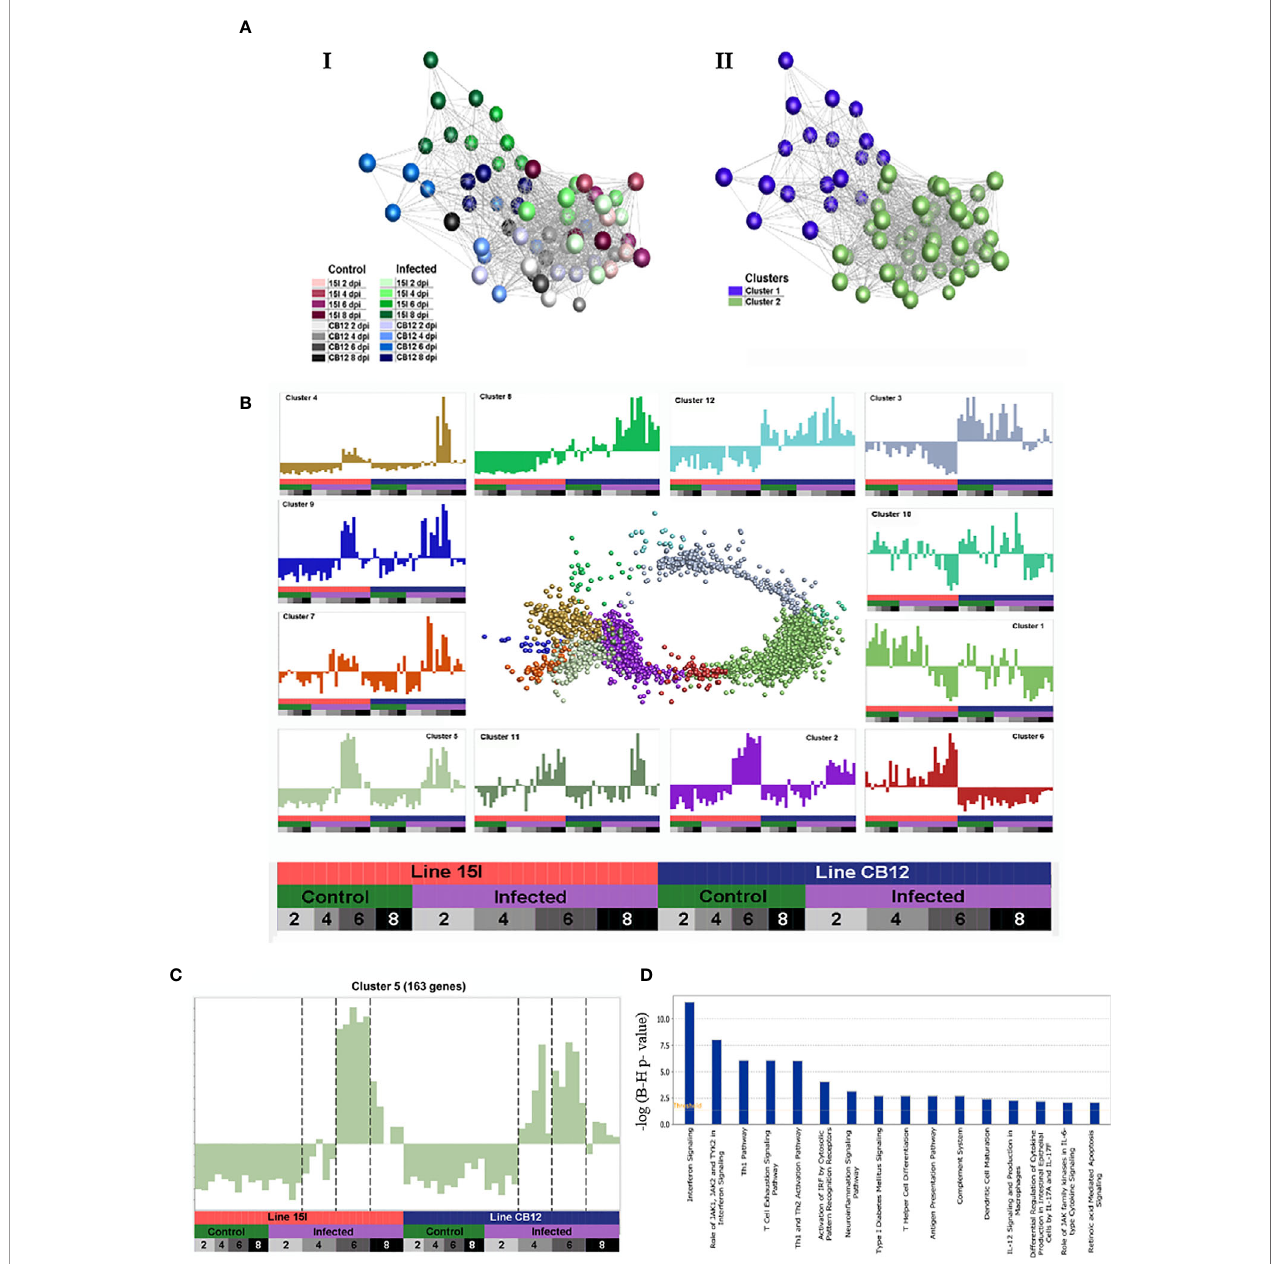
FIGURE 2 | A network graph of unbiased sample-to-sample and gene-to-gene clustering. Sample-sample networks colored by treatment group (A-I) and Markov clustering (A-II) . Gene-gene network graph of Markov clustered genes (B) , with normalized expression across samples (mean-centered scaling) of each cluster in the surrounding charts. Genes in cluster 5 (C) including IFN- g and IL-10 have strongly elevated expression at 6 dpi in both lines of chickens, but also earlier at 4 dpi in line C.B12 chickens. Pathways enriched in cluster 5 are shown in (D)